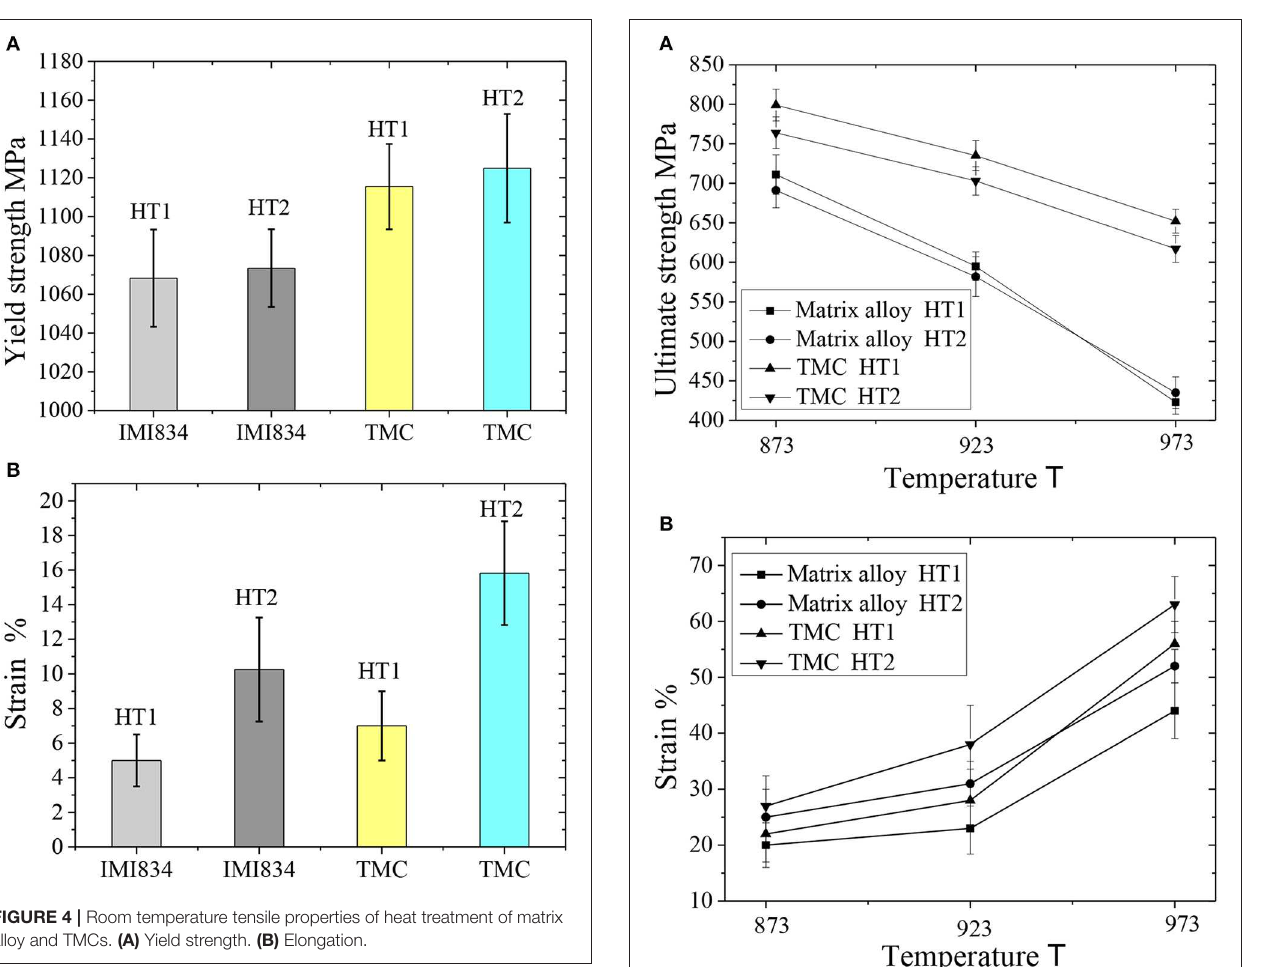
sliding is dominant when the stress exponent is 3.5, when the stress exponent is 4.6, dislocation climb is